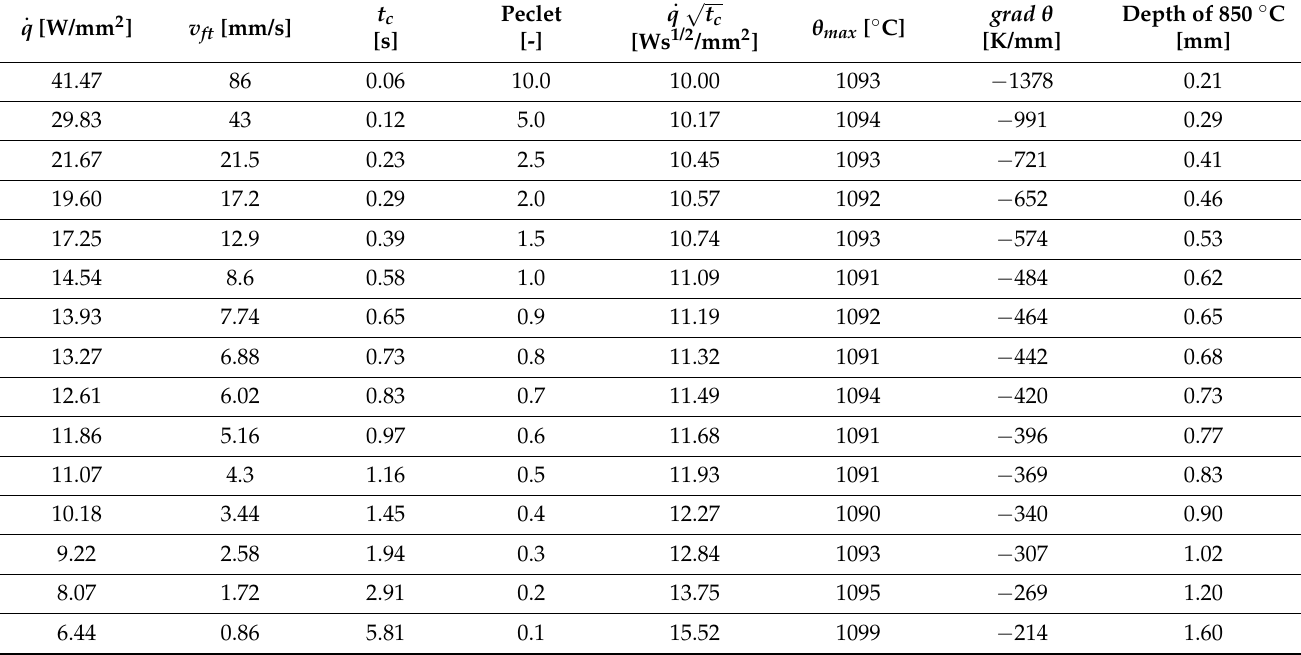
Table 4. Maximal temperature on surface and depth for reaching 850 ◦ C calculated according the analytical solution of a moving heat source for Peclet numbers between 0.1 and